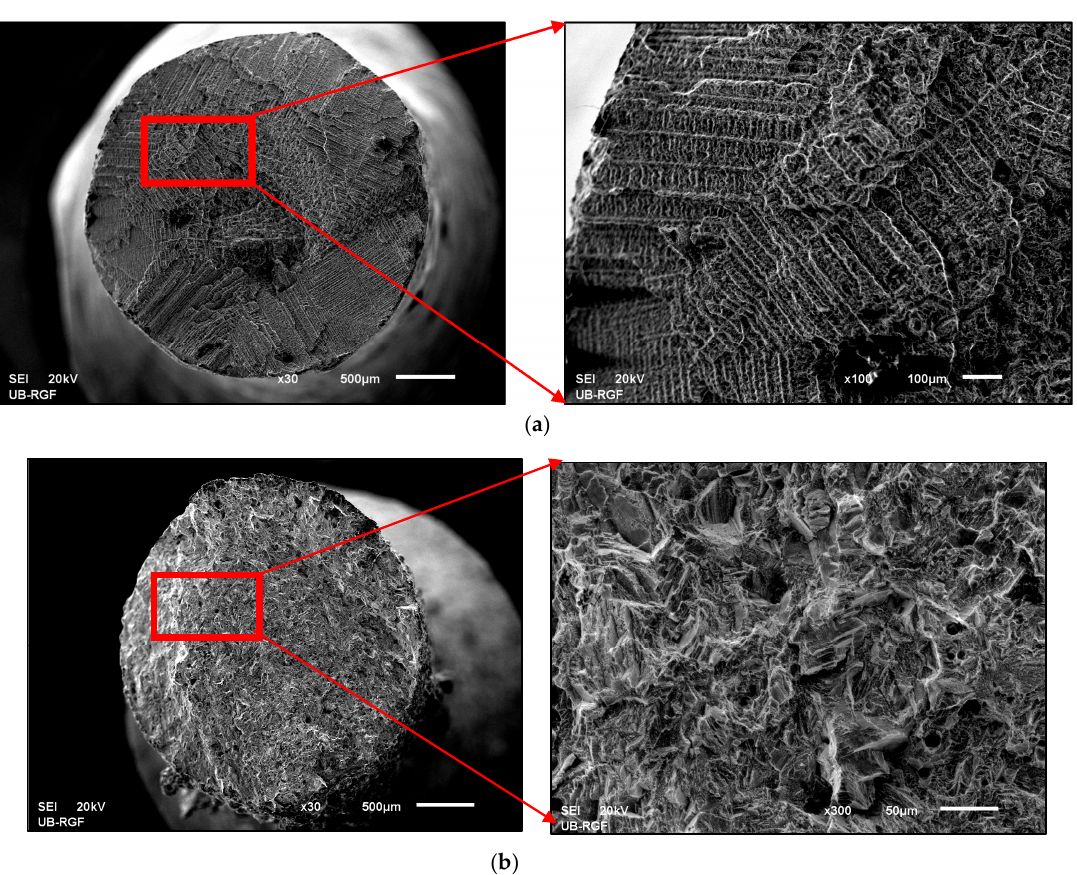
Figure 7. SEM microstructure of fracture surfaces of samples ( a ) C and ( b ) S3 (macro- and micro-